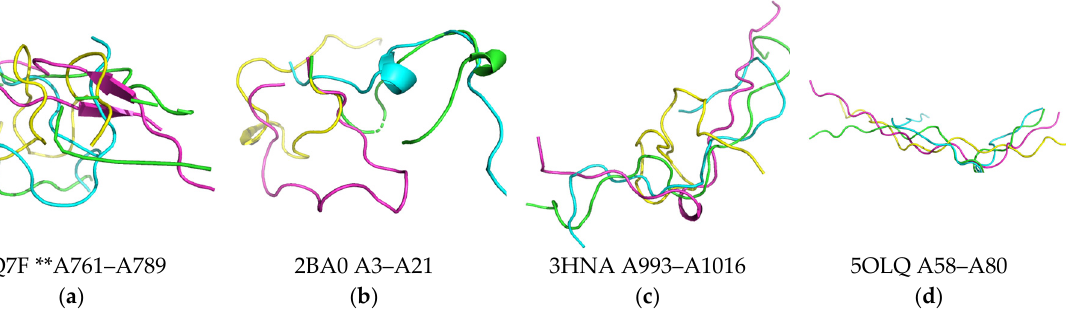
Figure 4. A set of overlapped protein structures used as a negative control. ( a ) Brain tumor protein (drosophila melanogaster) PDB ID 1Q7F region: A761–A789; ( b ) exosome complex component N-methyltransferase EHMT1 (homo sapiens) PDB ID 3HNA region: A993–A1016; ( d ) putative pectate lyase L (bacteroides thetaiotaomicron) PDB ID 5OLQ region: A58–A80. Color-scale legend: green color indicates structure in the protein composition (PDB data); blue, pink, and yellow colors define technical repetitions; **—chain A, region (PDB).